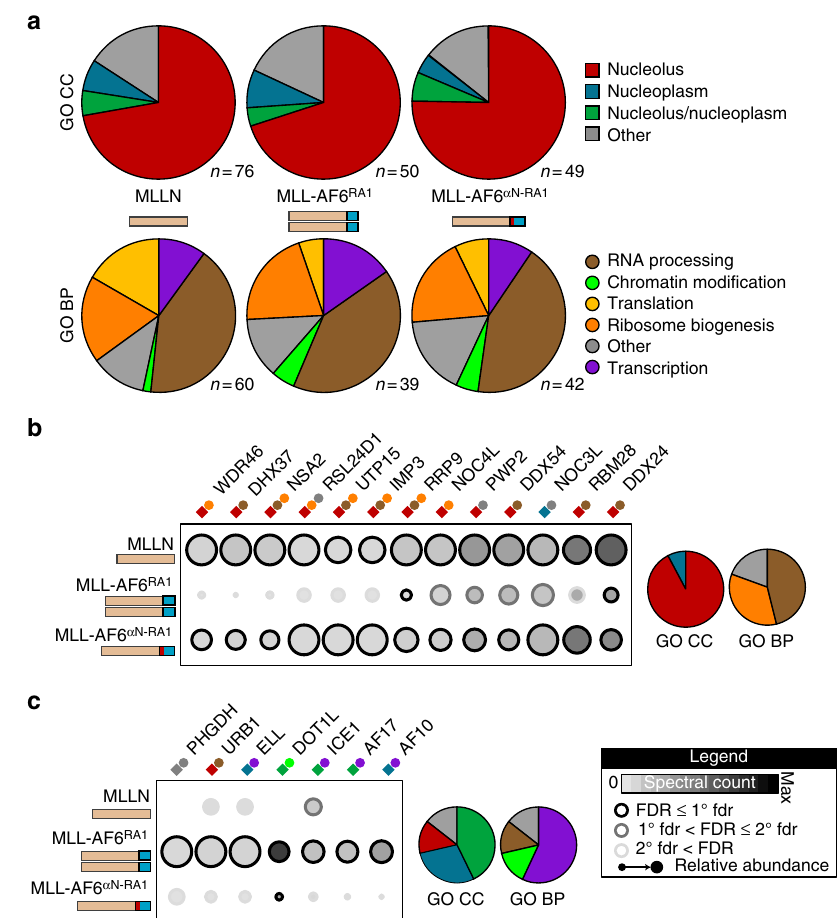
Fig. 5 BioID proteomics reveal protein partners speci fi c to monomeric and dimeric MLL-AF6 fusions. a Distribution of Gene Ontology (GO) cellular components (CC) denoting localization (top), and biological processes (BP) denoting protein function (bottom) of proteins associating with MLLN alone, the MLL-AF6 dimer (RA1, 37-136), or the MLL-AF6 monomer ( α N-RA1, 6-136). n indicates the total number of identi fi ed biotinylated proteins following SAINT analysis. The majority of associating proteins were nucleolar (red) for all baits, though MLL-AF6 37 – 136 has a higher ratio of proteins localized to the nucleoplasm. b Proteins biotinylated speci fi cally by MLLN and MLL-fused monomeric α N-RA1 domain. Annotation for GO CC (colored squares) and GO BP (colored circles) are from a . Chart summary of total CC and BP distributions are at right. c Proteins biotinylated speci fi cally by the dimeric MLL-fused AF6 RA1